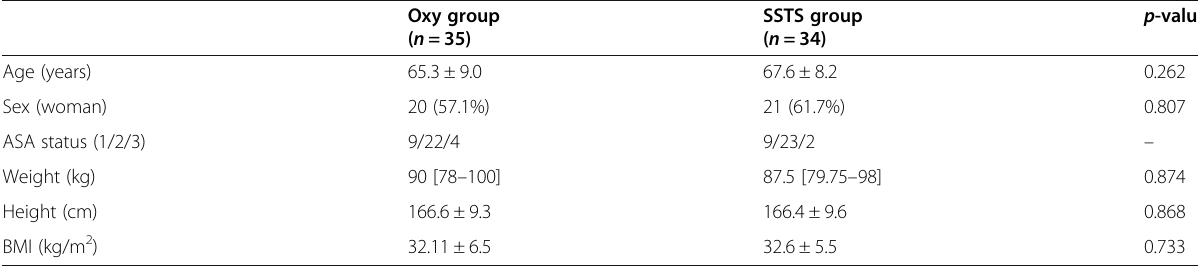
Table 1 Patients ’